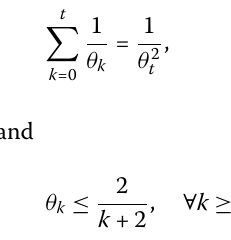
Algorithm . (PALM-IPR for Problem